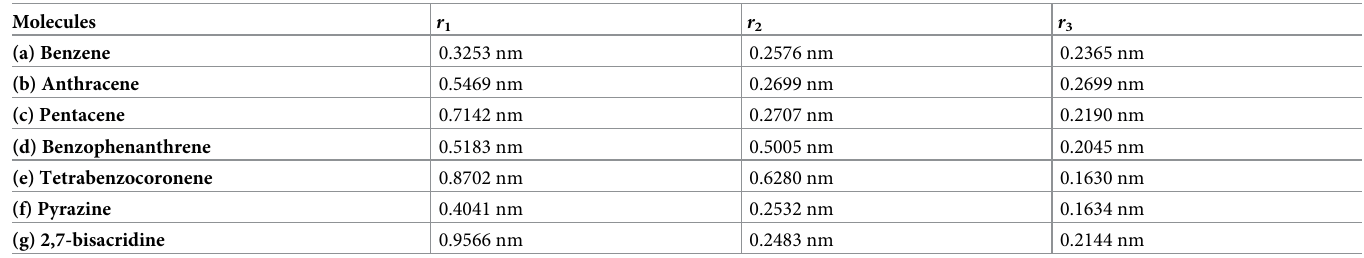
Table 2. Examples of estimated ellipsoid radii.